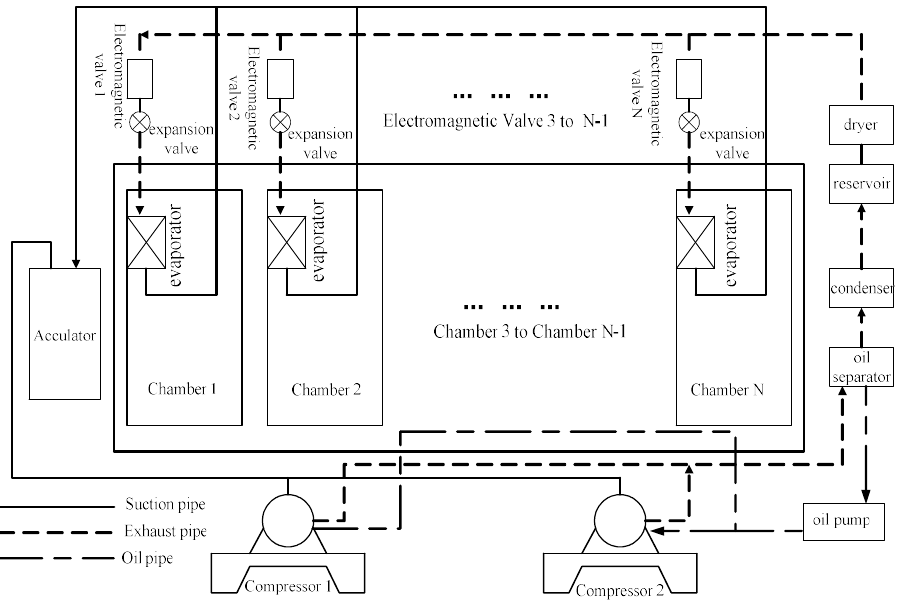
Figure 2. Refrigerated chamber.